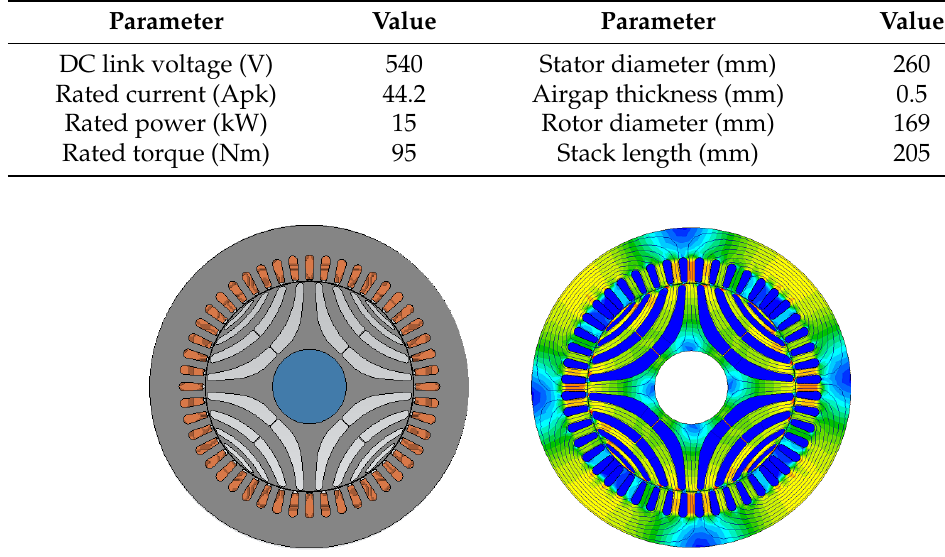
Figure 4. Cross-section of the SynRel FEA model ( left ) and an example of flux density map ( right ). A series of FEA simulations have been carried out according to the predefined ( i d , i q ) currents plane as 40 × 40 A. The computed flux maps for d - and q -axes are presented in Figure 5.